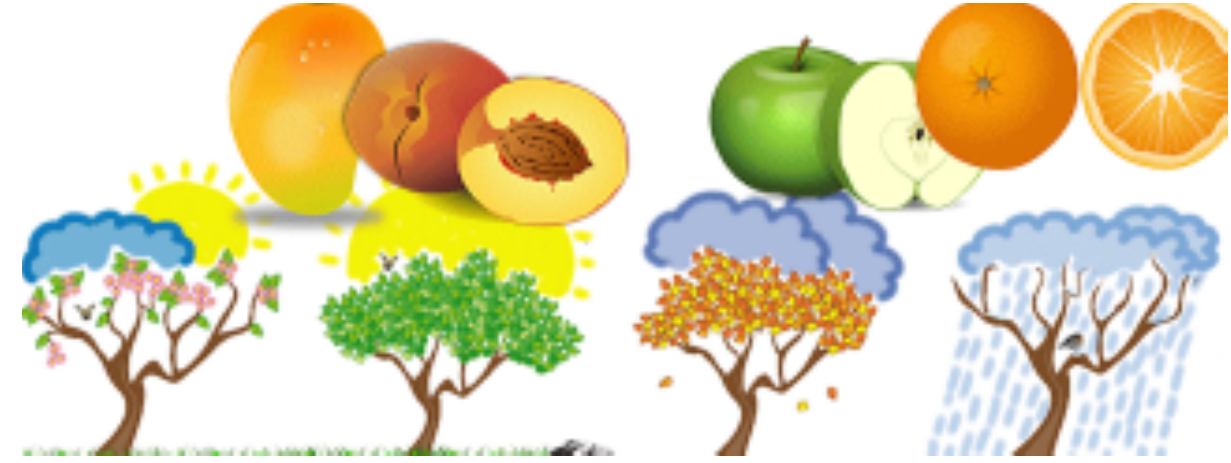
Figure 10. Seasons before